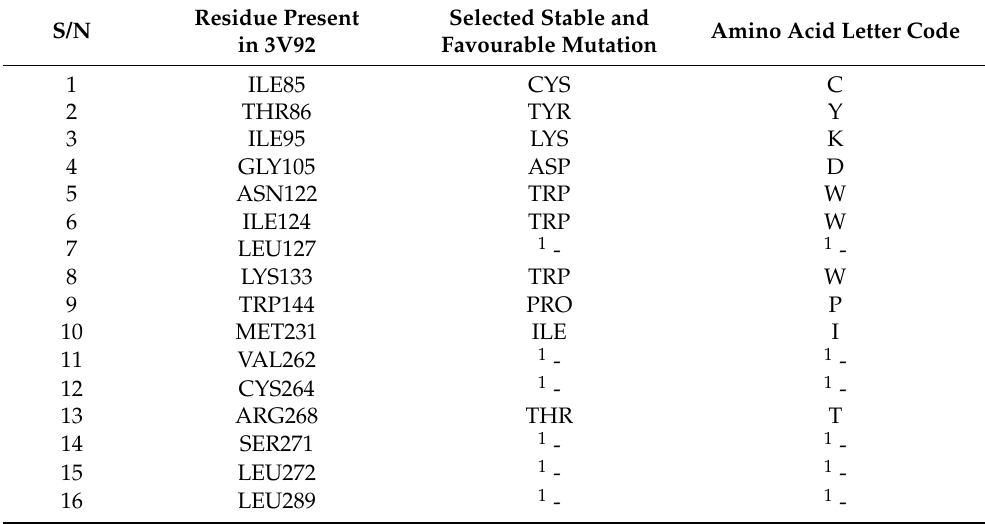
Table 1. Stable and favourable amino acid substitutions in non-conserved regions of LOX. Residue Present Selected Stable and Amino Acid Letter Code S/N in 3V92 Favourable Mutation